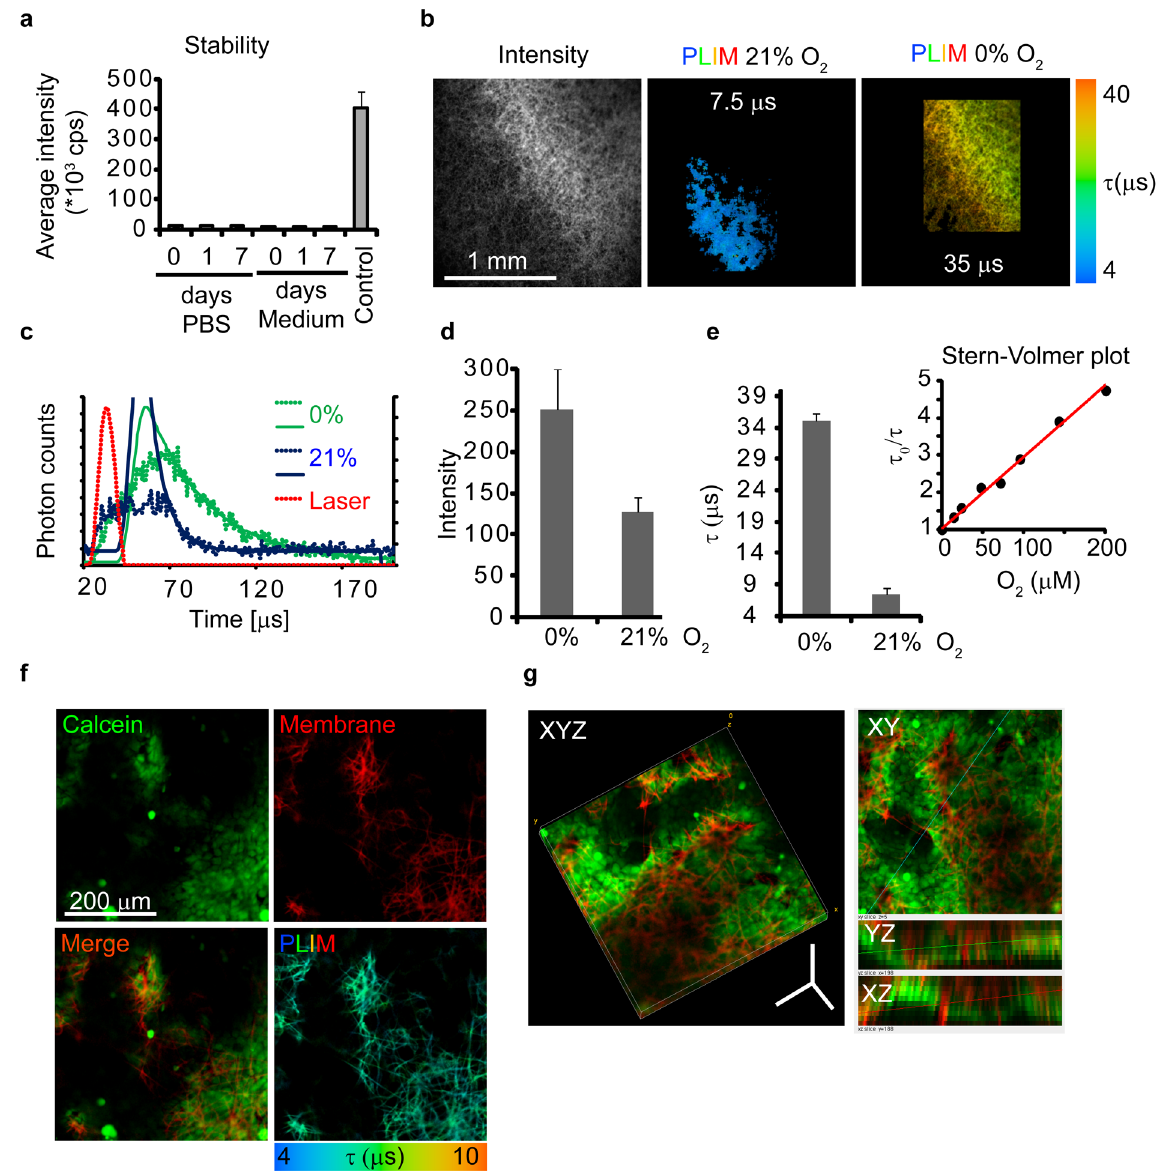
Figure 6. Application of fibrous electrospun membranes to O 2 sensing: ( a ) Stability of impregnated PtTFPP in PBS and cell culture medium during incubation at 37 °C. ( b ) Intensity map and phosphorescence lifetime imaging of stained membrane in PBS buffer at 21 kPa O 2 and after deoxygenation obtained by confocal PLIM. ( c ) Representative phosphorescence decay curves at 0 and 21% O 2 . ( d , e ) average phosphorescence intensities and lifetimes measured at 0 and 21% O 2 , respectively and Stern-Volmer relationship. ( f ) Confocal PLIM of live HCT116 cells cultivated on membranes. Images of cells (stained with Calcein Green) and membrane (red) and in PLIM (membrane only) are shown. ( g ) 3-D reconstruction of cells growing in membrane. Different projections are shown. Scale bar is in µ